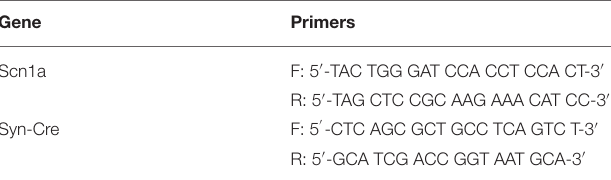
TABLE 1 | Sequences of primers used for genotyping by PCR.